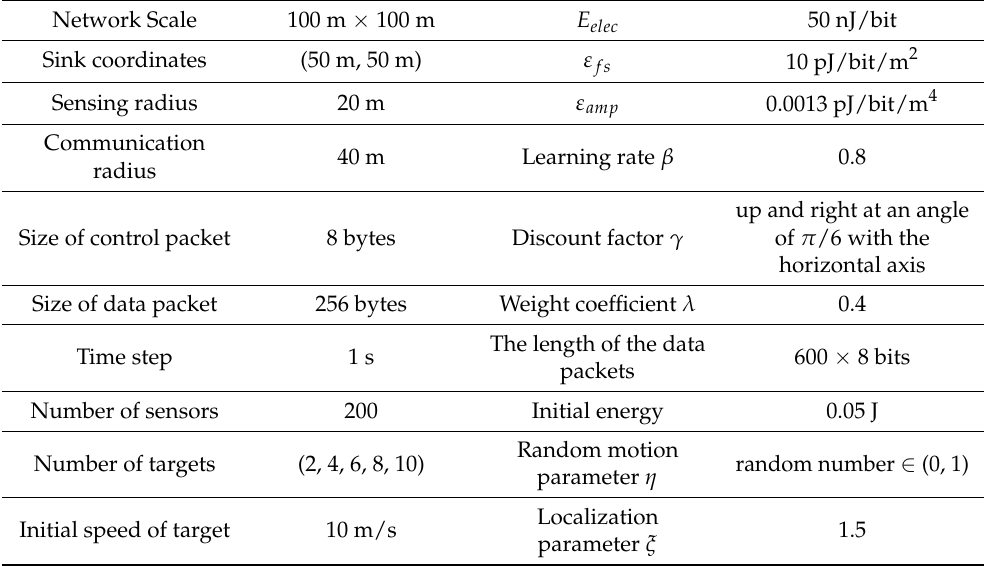
Table 1. Simulation parameter